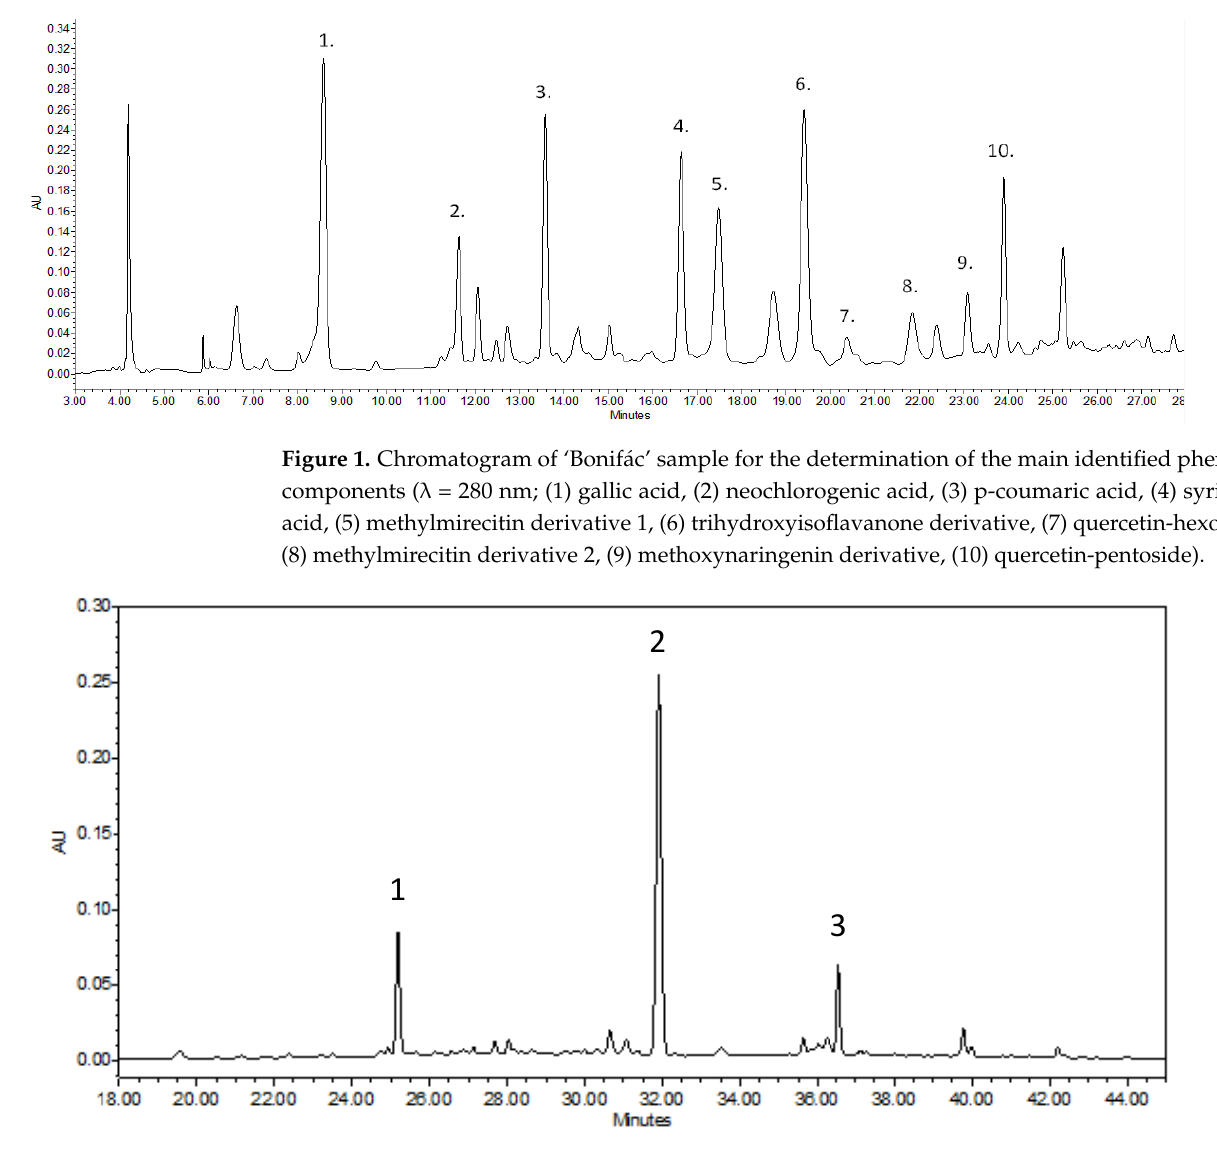
Figure 2. Chromatogram of ‘Bonif á c’ sample for the determination of juglone ( λ = 420 nm).